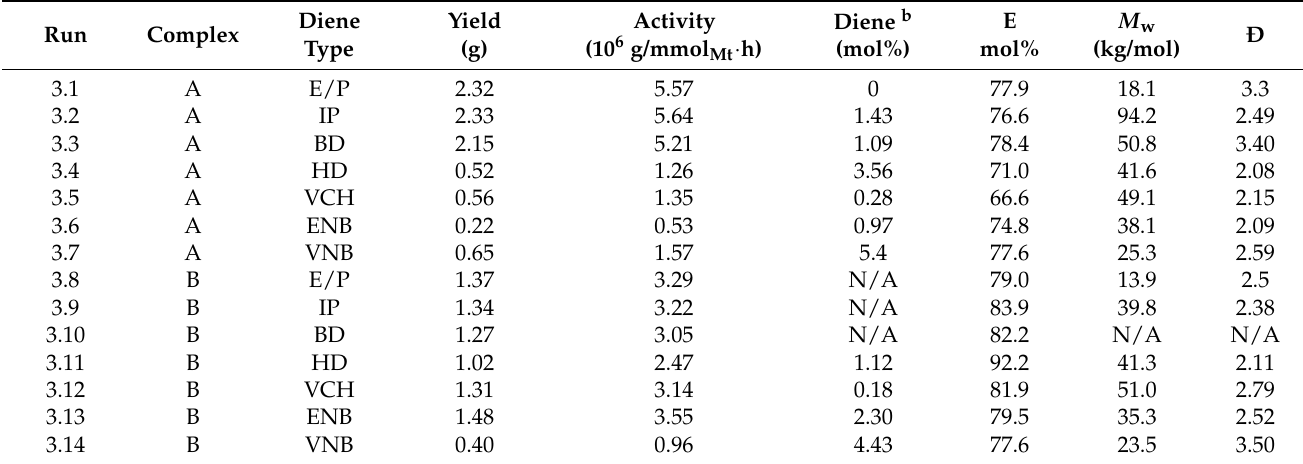
Table 3. Ethylene, propylene and diene (conjugated and nonconjugated) terpolymerization a .